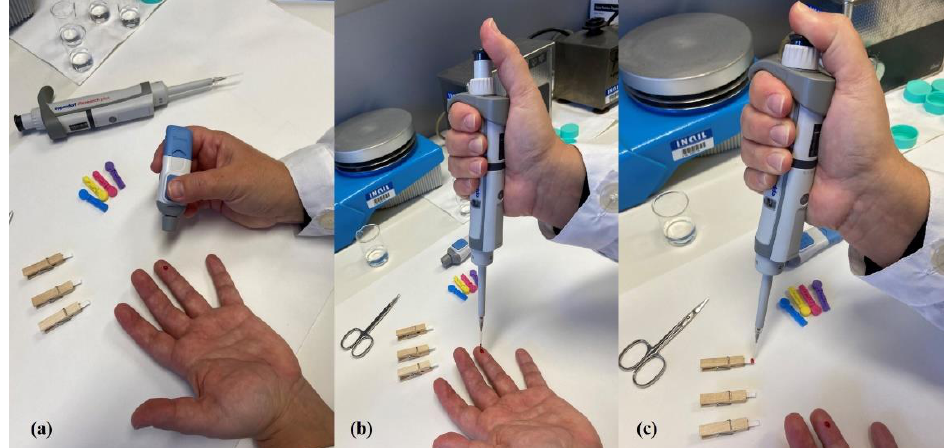
Figure 1. Three pictures that summarize the whole blood sampling procedure. Blood was taken with a lancing device (Panel ( a )) and 2 µL were collected with a pipette (Panel ( b )); finally, it was loaded on the paper support (Panel ( c )). One of the authors has volunteered to carry out the sam- pling on herself in order to show how easy it is to carry out the procedure alone if necessary.